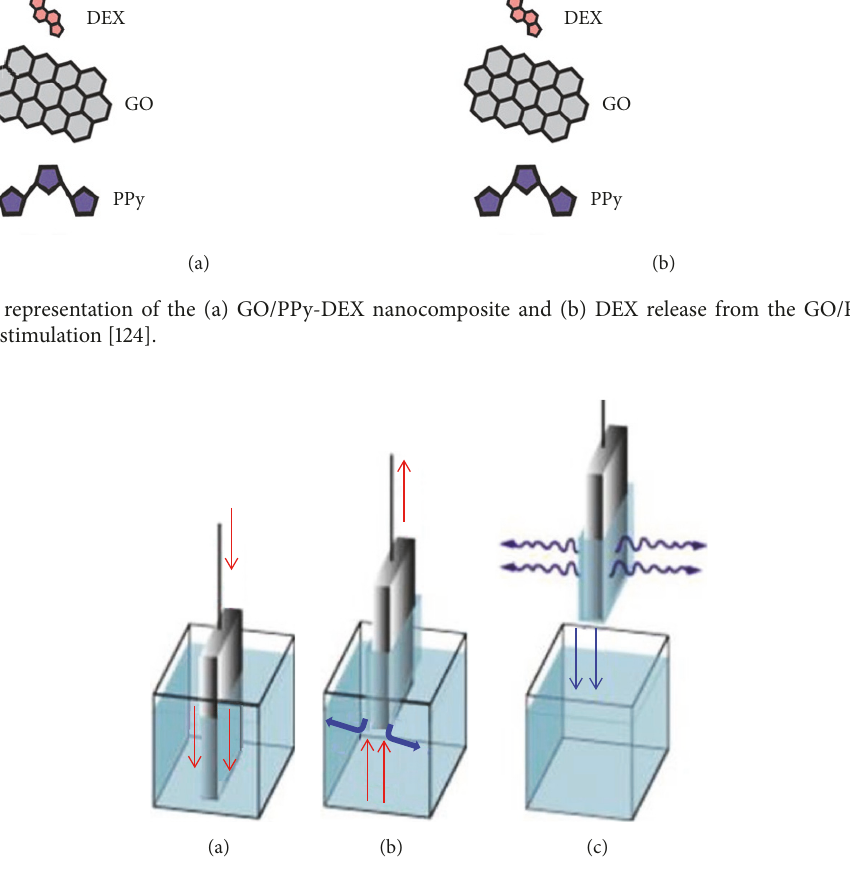
Figure 6: The dip coating: (a) submersion of the substrate in the nanocomposite solution, (b) withdrawing at constant speed of the substrate covered with nanocomposite, and (c) evaporation of the